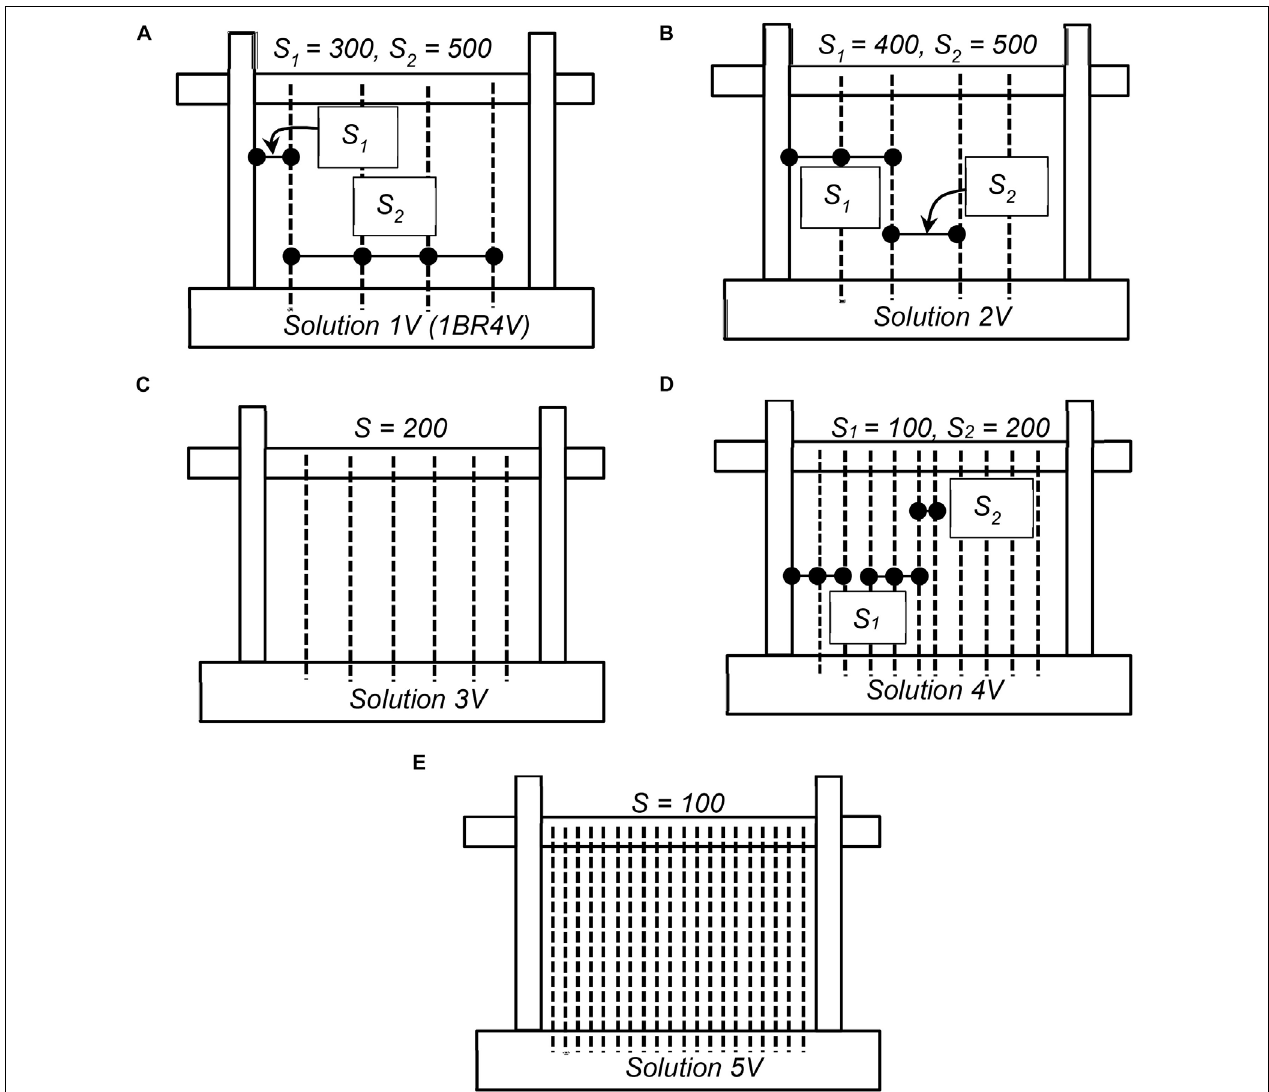
FIGURE 6 | Retrofit solutions with vertical NSM bars: (A) solution 1V (1BR4V), (B) solution 2V, (C) solution 3V, (D) solution 4V, and (E) solution 5V.